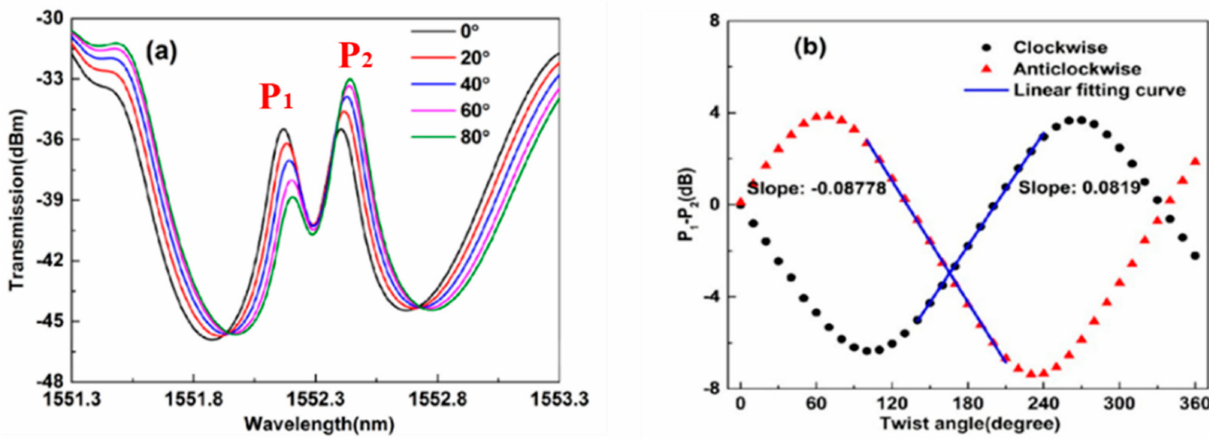
Figure 12. ( a ) Transmission spectra of the proposed PS-FBG under different torsion angles. ( b ) The relationship between the transmission difference P 1 − P 2 and the applied torsion. Adapted with permission from ref. [17]. © The Optical